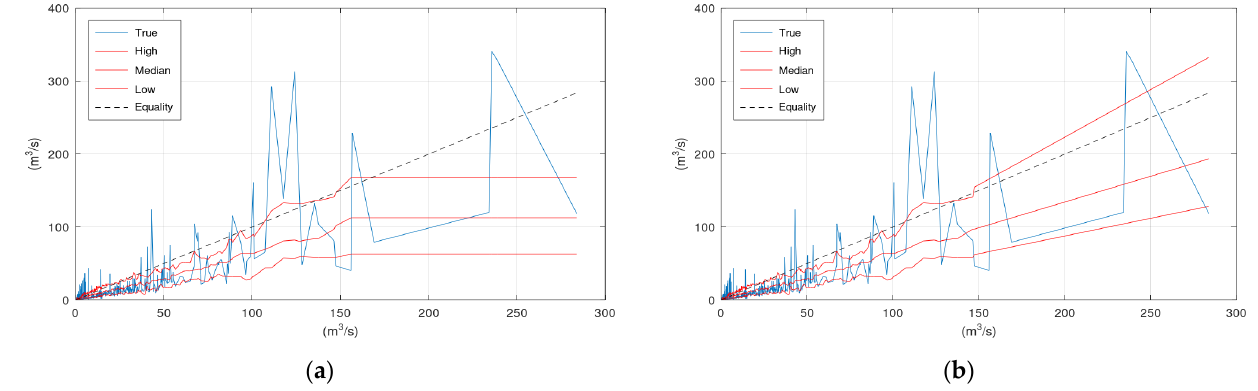
Figure A4. Scatter plot of Arno River case study: ( a ) KNN applied to the trimmed training data set; ( b ) KNN with linear extrapolation applied to the trimmed training data set.